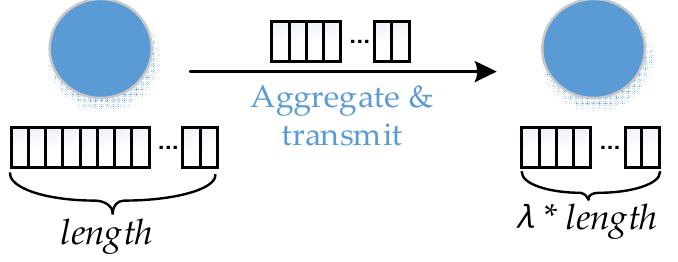
Figure 2. Aggregation reduces the length of the aggregation queue.